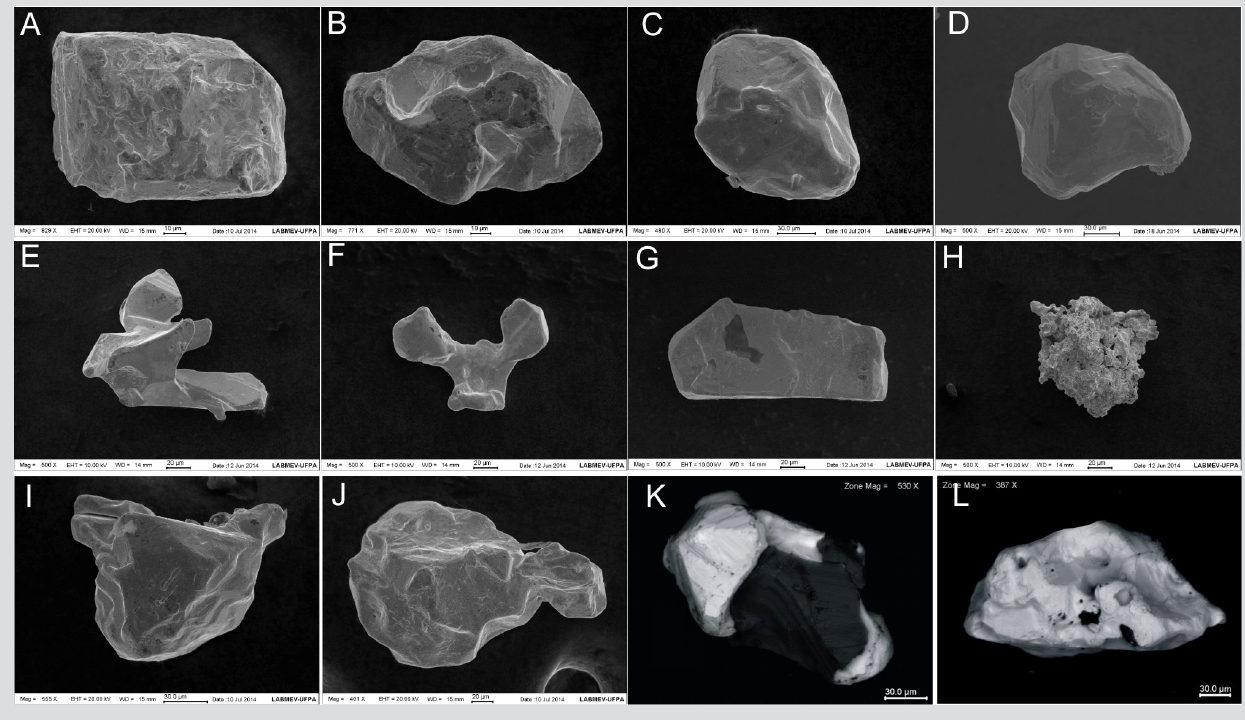
Figure 12 - Backscattered electron images of individual gold particles from the matrix of metaconglomerate showing the variation in morphology. (A) and (B) Rectangular to ellipsoidal with rounded to subrounded terminations. (C) and (D) Equant, rounded or blunted. (E) and (F) Irregular. (G) Elongated. (A to G have smooth surfaces). (H) Spongy. (I) and (J) Irregular with rounded to subrounded terminations and rather rugose surface. (K) Gold in contact with magnetite. Note the relict shape of the particle. (L) Irregular particle with cavities and inclusion of